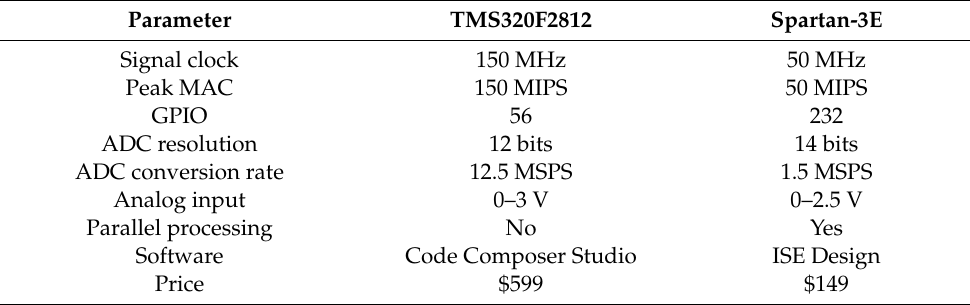
Table 3. Selected features of the TMS320F2812 and the Spartan-3E [16,17,19,20].